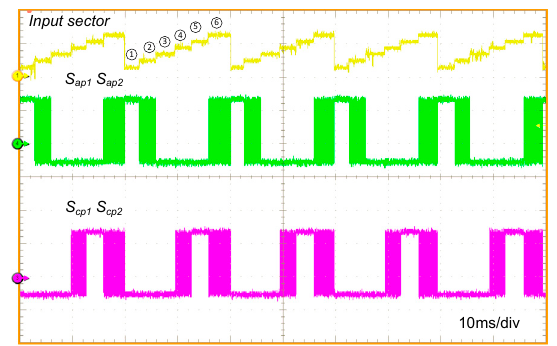
Figure 13. Input sector and the PWM signals of rectifier stages.